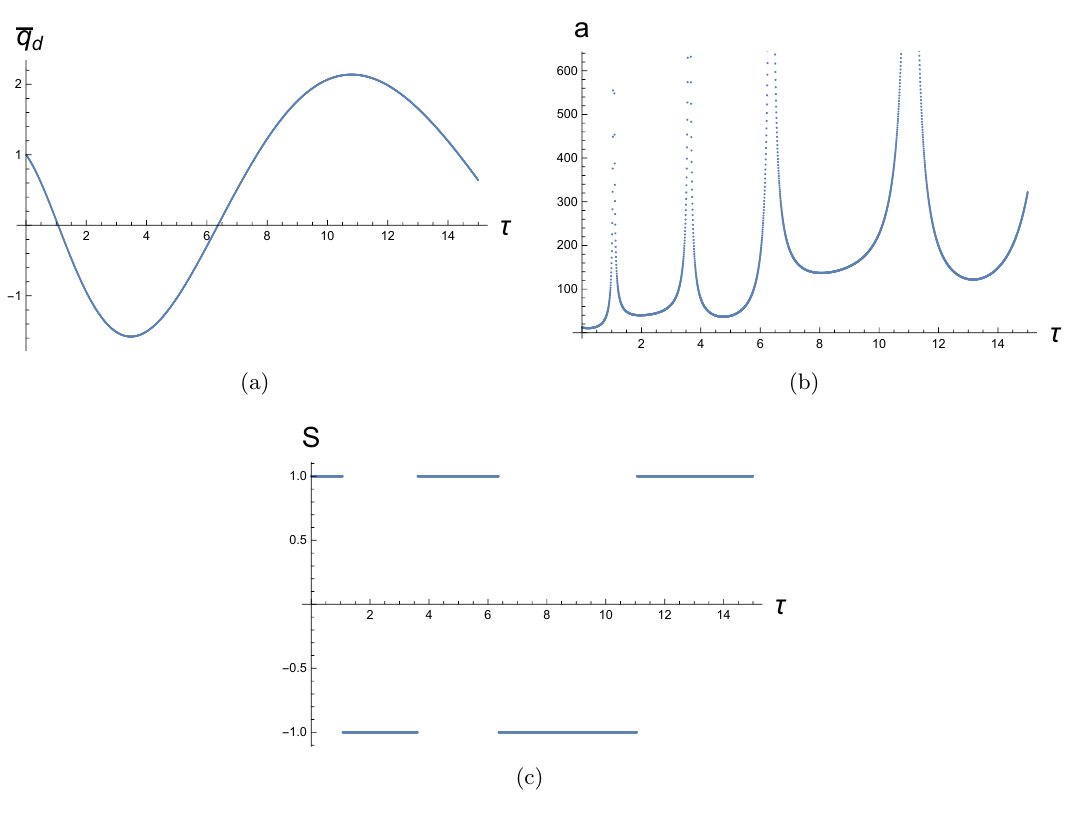
Figure 11 . (cid:22) q d , a , S plotted as a function of (cid:28) . Here, (cid:22) q d is the scalar de(cid:12)ned in eq. (6.16). a is the scale factor of the space de(cid:12)ned by g (cid:22)(cid:23) = a(cid:14) (cid:22)(cid:23) for the space with the translational symmetry and the re(cid:13)ection symmetry. S is the signature of